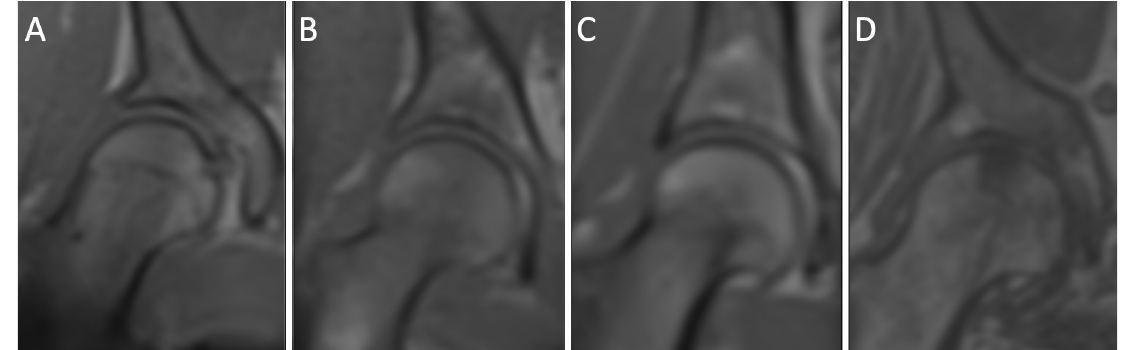
Fig 1. Examples of T1 vibe dixon in phase of the degenerative states of the OA MRI score. A: Grade 0 –no degeneration; B: Grade 1 – Slight narrowing of the medial joint gap and small osteophytic lipping; C: Grade 2 –narrowing of the medial joint gap and increased osteophytic lipping; D: Grade 3 –loss of the medial joint gap, osteophytic lipping as well as pseudocystic lesions.